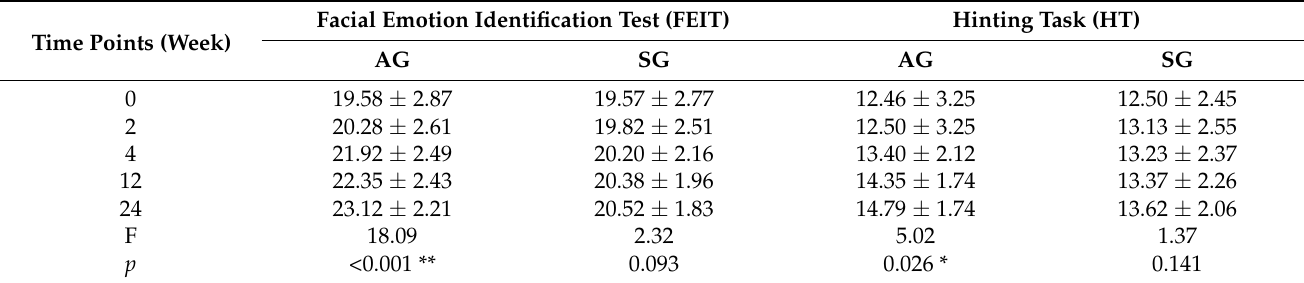
Table 3. Comparison of FEIT and HT scores between the two groups across the assessment time points.